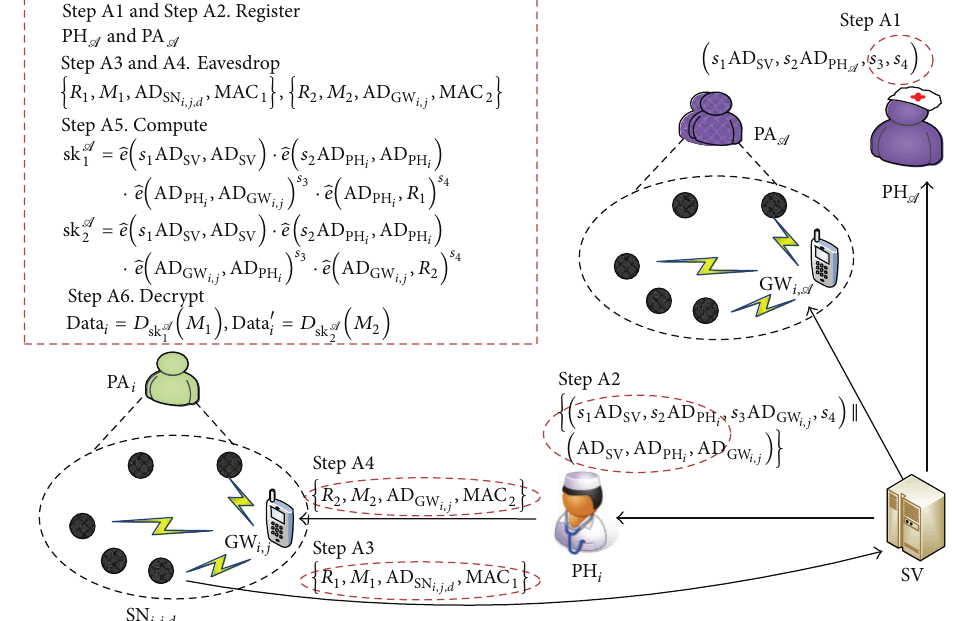
Figure 4: Security against collusion